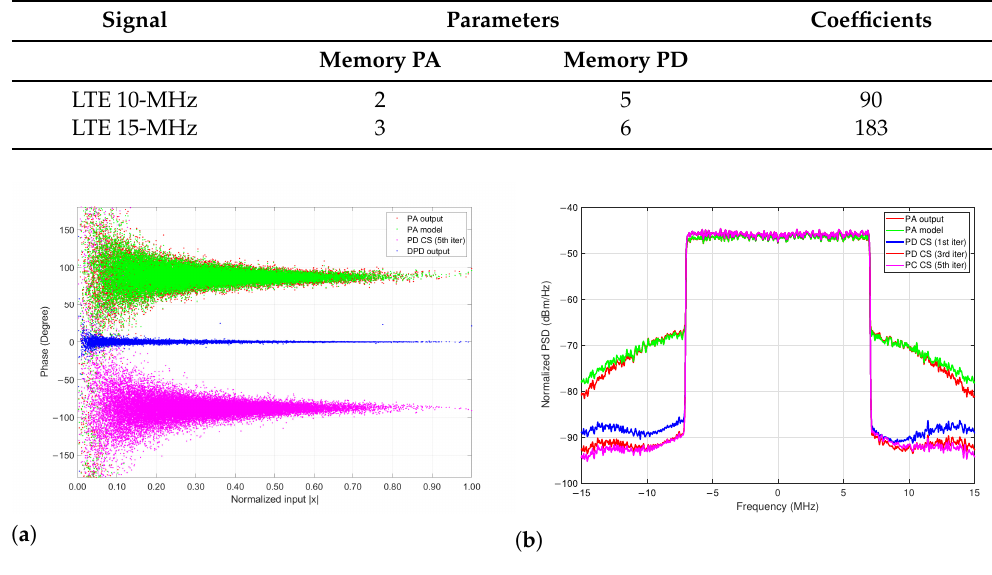
Figure 16. LTE 15-MHz PA output signal: ( a ) Construction process of the AM-PM characteristic model and ( b ) PSD for the LTE 15-MHz PA output signal and the iterative PD CS linearization result. Table 2. NMSE and runtime convergence for the LTE 10-MHz and LTE 15-MHz